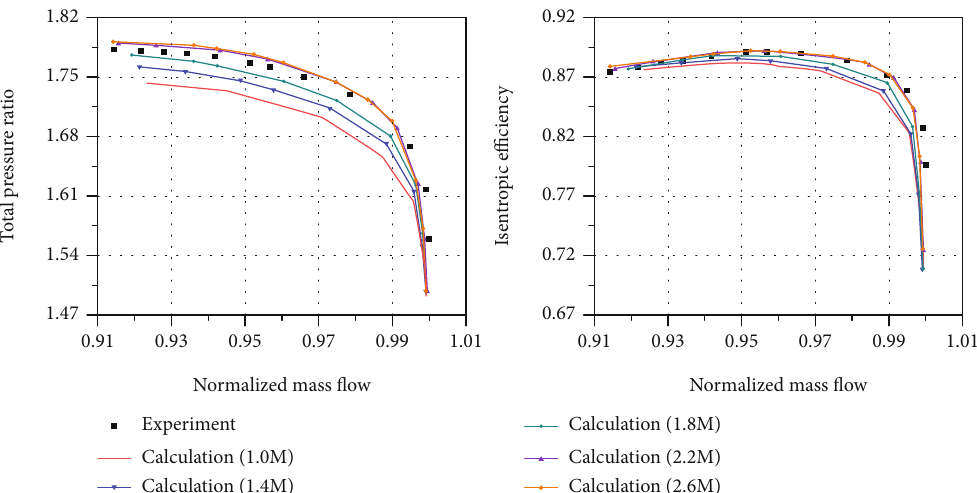
Figure 3: The calculation results of the fi ve di ff erent meshes.